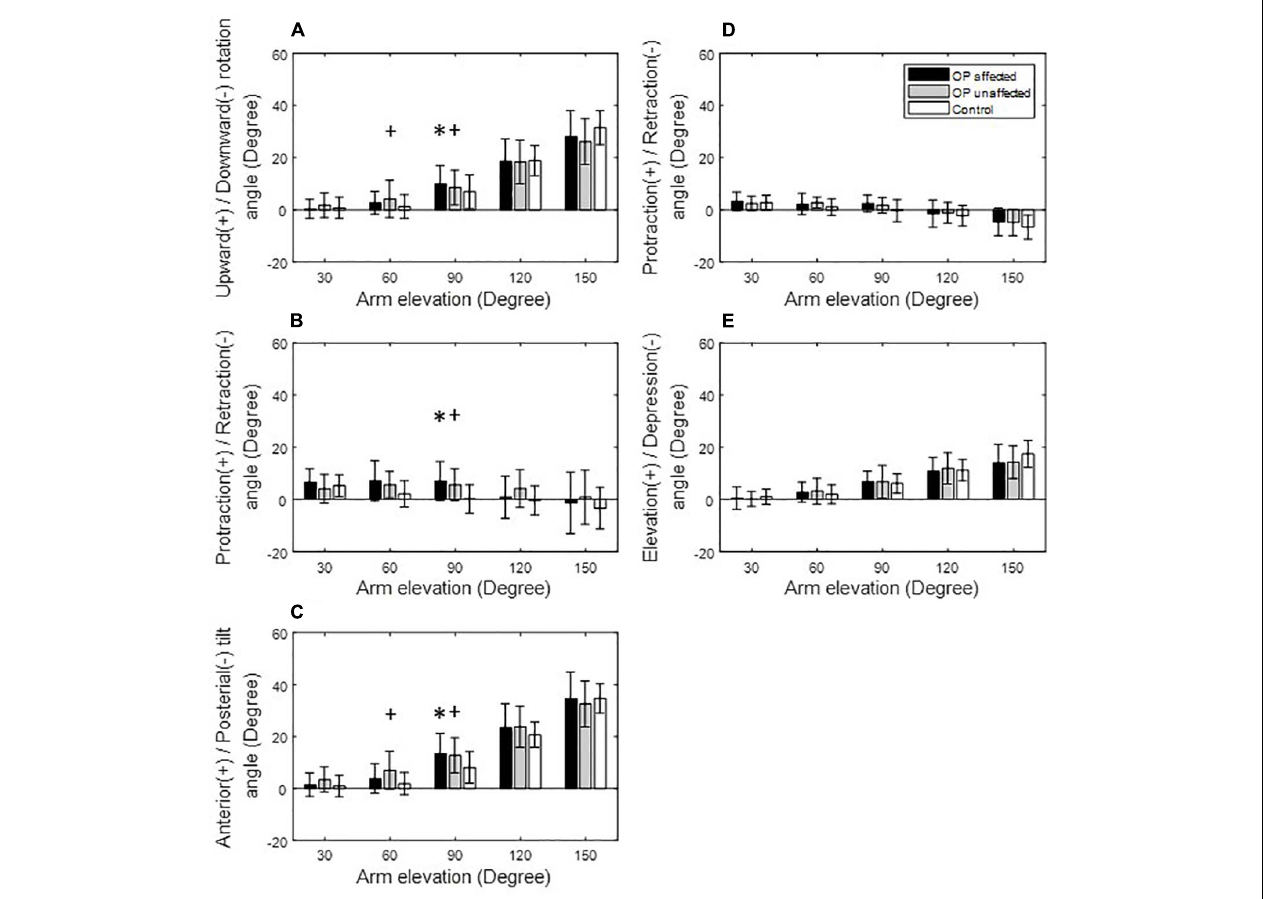
FIGURE 4 | Means and standard deviations of the kinematic components of the scapula (A–C) and clavicle (D,E) for the affected side (black bars), unaffected side (gray bars) of the patients, and for healthy controls (white bars) during arm elevation in the scapular plane. Symbol “ ∗ ” indicates a significant difference between the affected side and healthy controls. Symbol “+” indicates a significant difference between the unaffected side and healthy